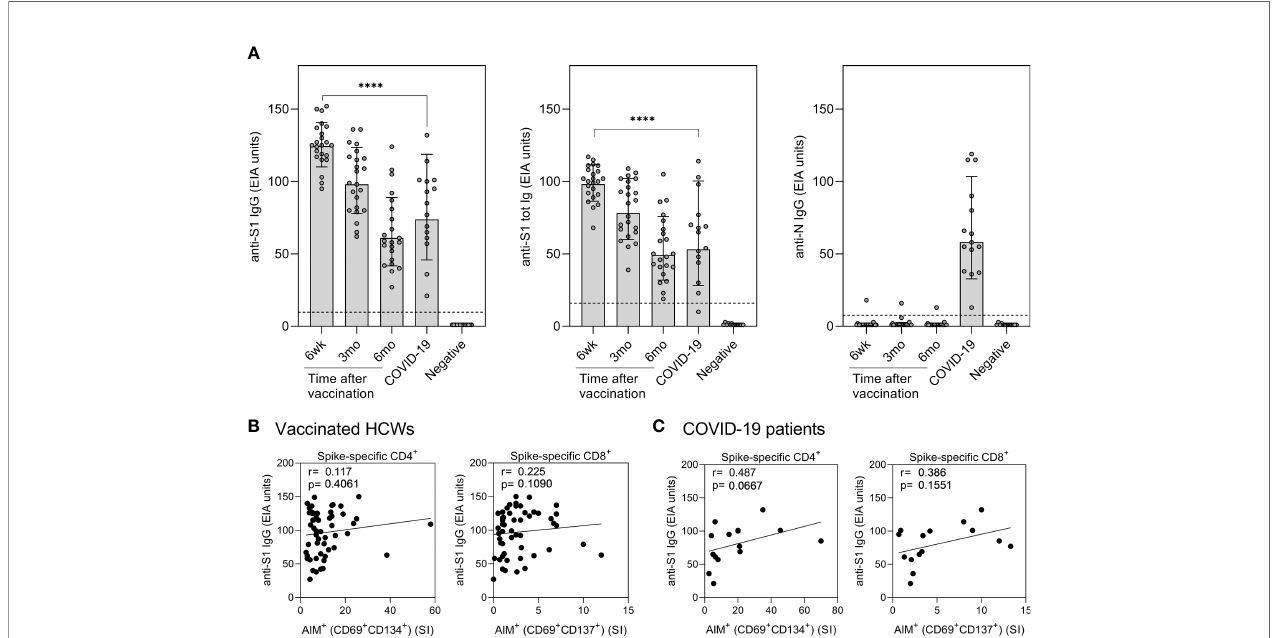
FIGURE 6 | Correlation of humoral immunity to cell-mediated immunity after BNT162b2 vaccination n = 23 and SARS-CoV-2 infection. (A) Anti-SARS-CoV-2 S1-speci fi c IgG, S1 total Ig, and N protein-speci fi c IgG antibody responses were measured from samples collected at 6 weeks, 3 months, and 6 months after vaccination n = 23 or 1 month after PCR con fi rmed SARS-CoV-2 infection (n=15). Serum antibody levels of vaccinated and infected individuals were compared with negative controls (n=13) that had not received any COVID-19 vaccines or suffered from a previous SARS-CoV-2 infection. Bars represent the geometric mean titers. The cut-off values for a positive test result are shown with dotted line Statistical analysis was performed with Mann Whitney U-test for comparison of 6wk vaccinee samples with COVID-19 patient samples. ****p<0.0001. (B,C) The correlation of anti-SARS-CoV-2 S1 IgG antibody levels with SARS-CoV-2 (wt) spike speci fi c CD4 + and CD8 + T cell responses in (B) vaccinated HCWs (samples collected 6 week, 3 months, and 6 months after vaccination, n= 52) and (C) COVID-19 patients (samples collected 1 month post onset of symptoms, n=15). Correlation was analyzed with the Spearman ’ s correlation and Spearman ’ s r is indicated in the fi